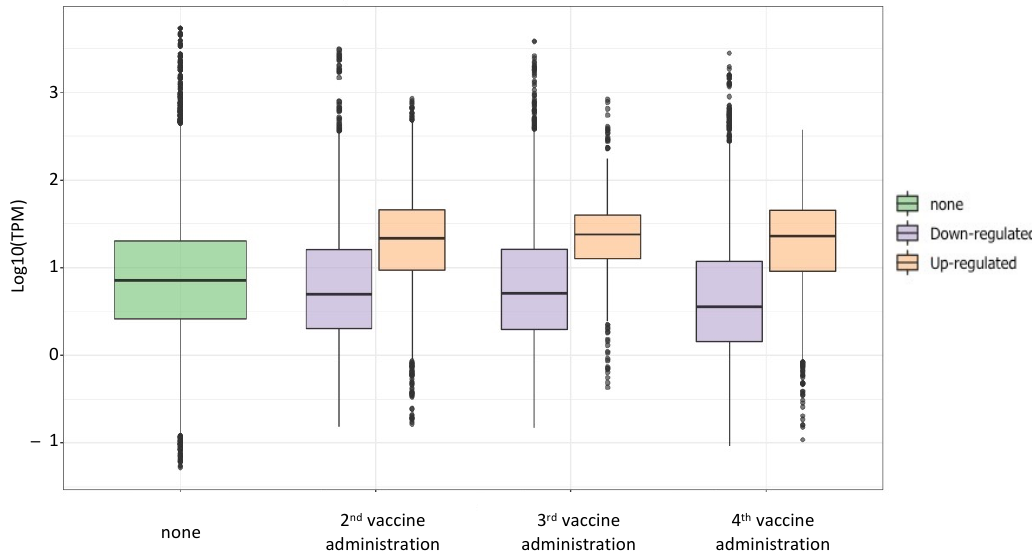
Figure 5. Expression levels of differentially expressed hervgdb4 after the 2nd, 3rd, and 4th vaccine administration. The boxplot represents the TMP values of the hervgdb4 fragments that were differentially expressed after each vaccine administration compared to the baseline (not vaccinated samples).